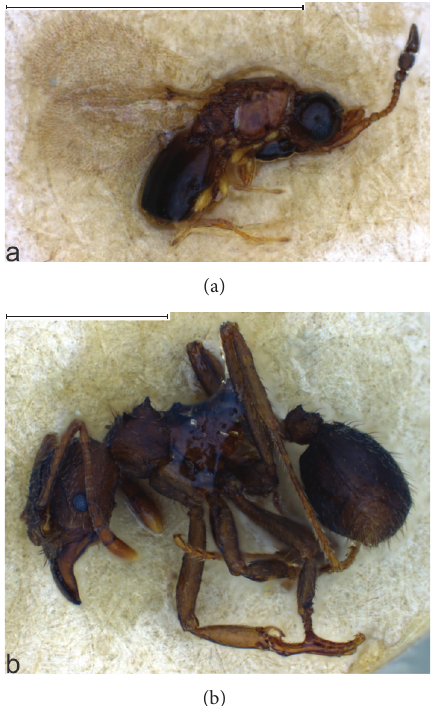
Figure 3: (a) Doliopria myrmecobia female in lateral view. (b) Acromyrmex lundii. Scale: 1 mm.